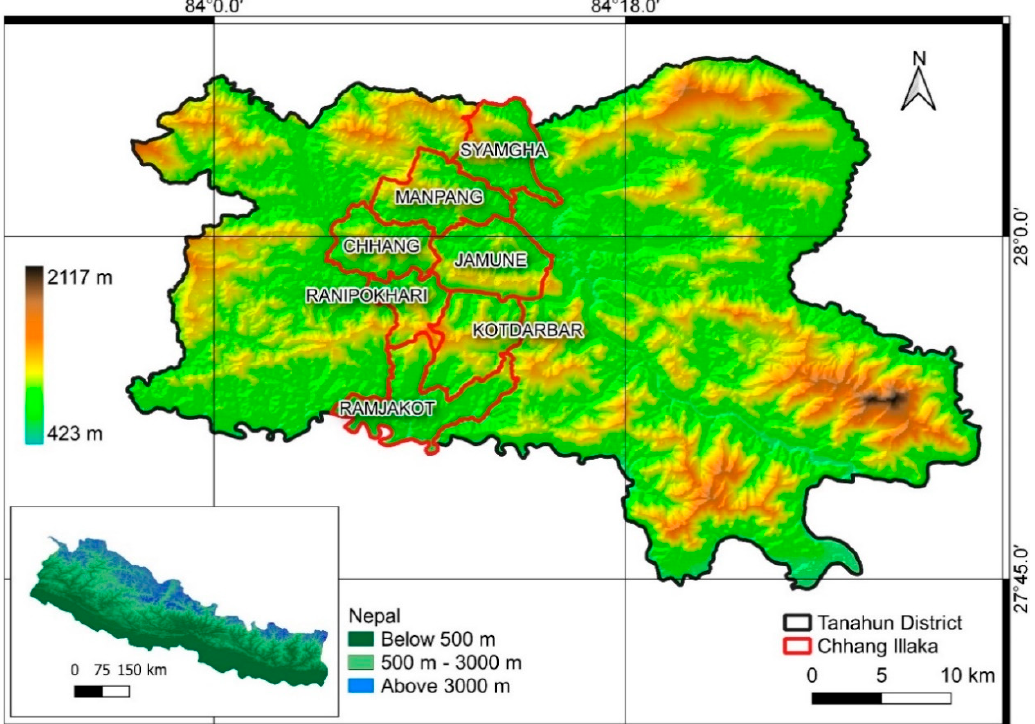
Figure 1. Study area map showing the Tanahun District and Chhang Range.